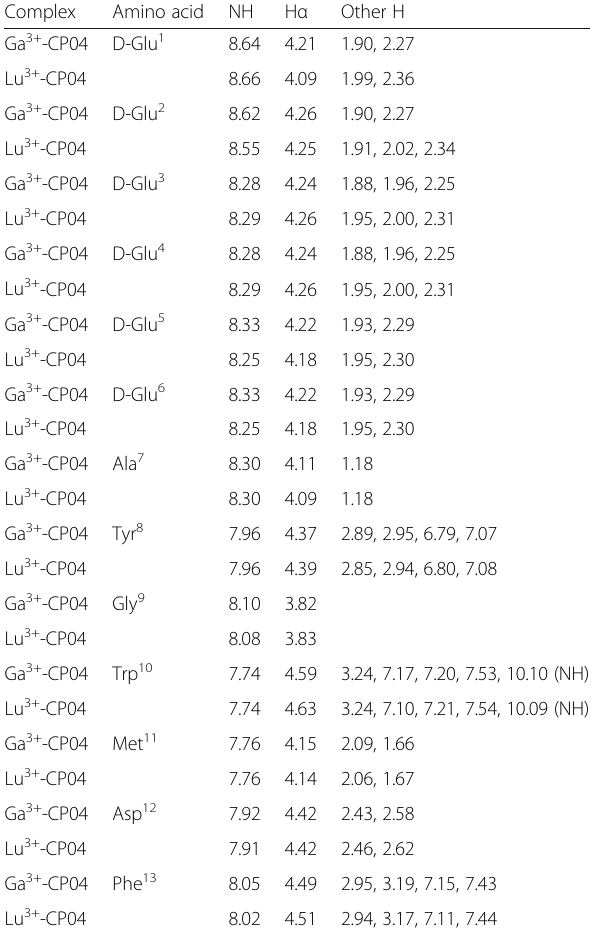
Table 2 1 H chemical shifts (in ppm) of the Ga 3+ -CP04 and Lu 3+ -CP04 complexes